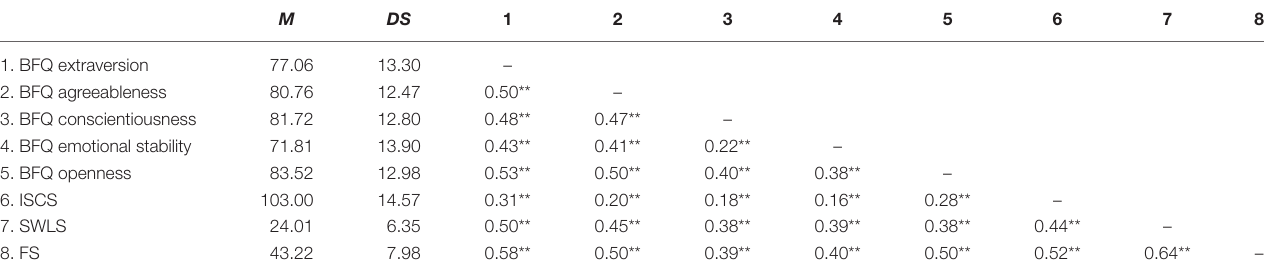
TABLE 1 | Means, standard deviations, and correlations between BFQ, ISCS, SWLS, and FS.